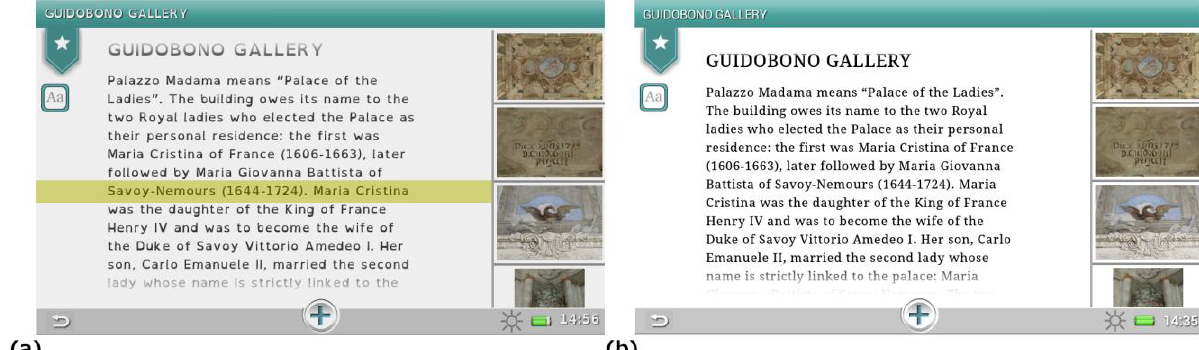
Figure 7. A screenshot of the interface for dyslexic users ( a ), which, compared to the version for non-dyslexic users ( b ), shows the usage of the OpenDyslexic font, a